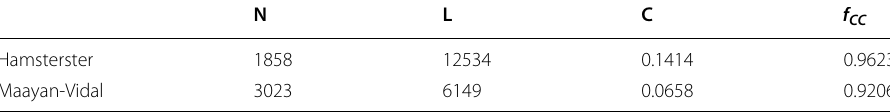
Table 2 Properties of the empirical networks. N is the number of nodes, L is the number of links, C is the clustering coefficient of the network, and f CC is the fraction of nodes that belong to the largest connected component in the